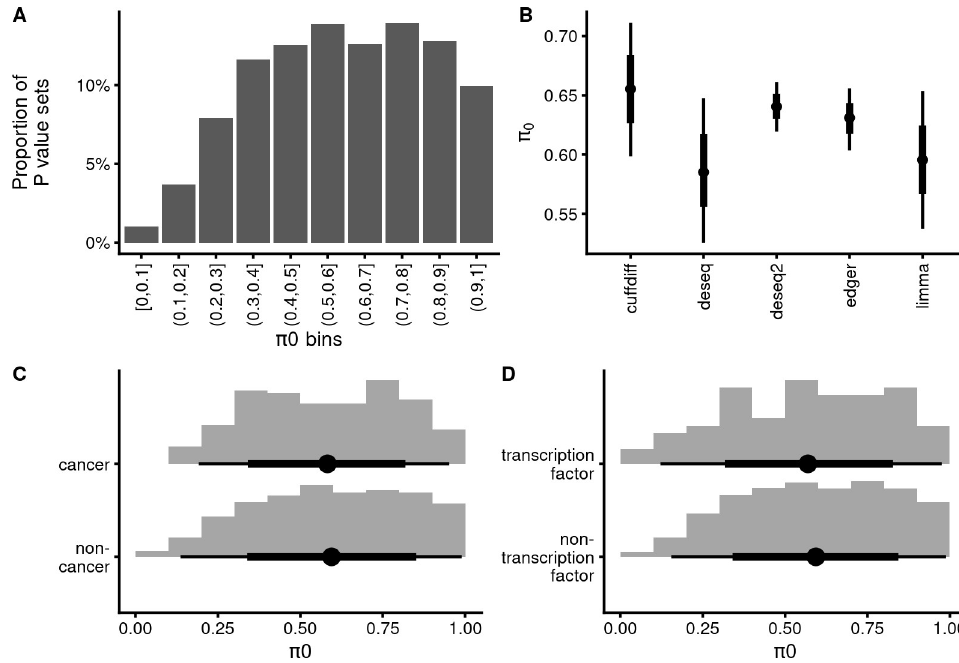
Fig 3. Association of the proportion of true null effects ( π 0 ) with DE analysis tool. ( A ) Histogram of π 0 values estimated from anti-conservative and uniform p -value sets. N = 1,188. The data file is in S3 Data. ( B ) Robust linear model [pi0 ~ de_tool, beta likelihood] indicates an association of π 0 with the DE analysis tool. Points denote best estimates for the mean π 0 and thick and thin lines denote 66% and 95% credible intervals, respectively. N = 1,188. The data file is in S4 Data. ( C ) Histogram of π 0 values in GEO cancer studies compared to non-cancer studies. The data file is in S5 Data. ( D ) Histogram of π 0 values in GEO transcription factor studies compared to non-TF studies. The data file is in S6 Data. The model object related to panel B can be downloaded from https://gin.g-node.org/tpall/geo-htseq-paper/ src/v0.1/models/pi0_detool_sample.rds.